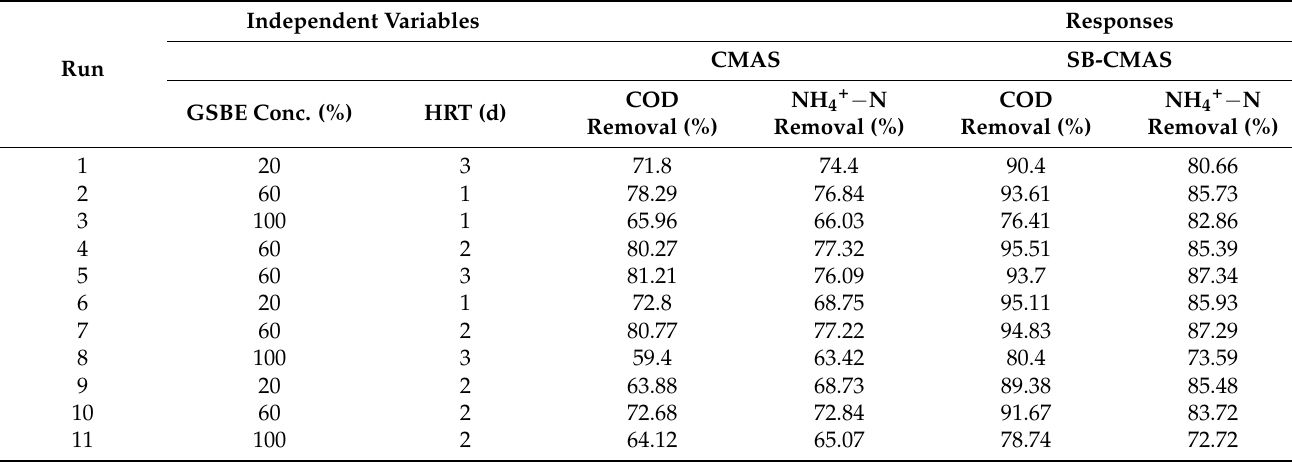
Table 4. Design of experiment for the optimization of COD and NH 4+ − N